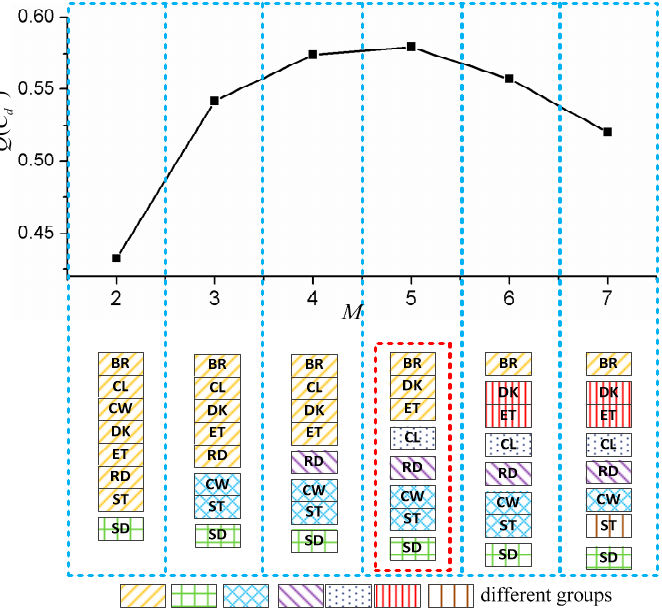
Figure 9. Results of group selection method.